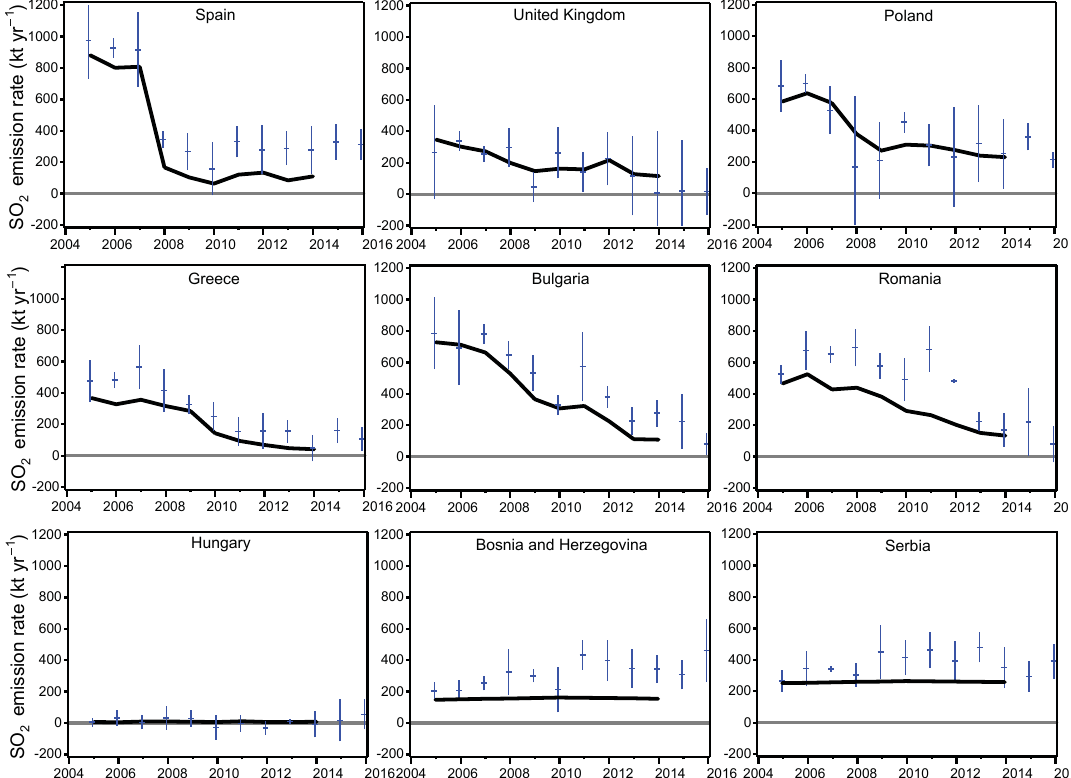
Figure 6. OMI-based (blue bars) and reported/estimated (black lines) emissions for different European countries. E-PRTR reported emissions were used for all countries except Serbia and Bosnia and Herzegovina, where TNO-MACC estimates (Kuenen et al., 2014) were used (see Supplement). The error bars represent 2 standard errors of the annual mean calculated by averaging three seasonal (spring, summer, autumn) OMI-based emission